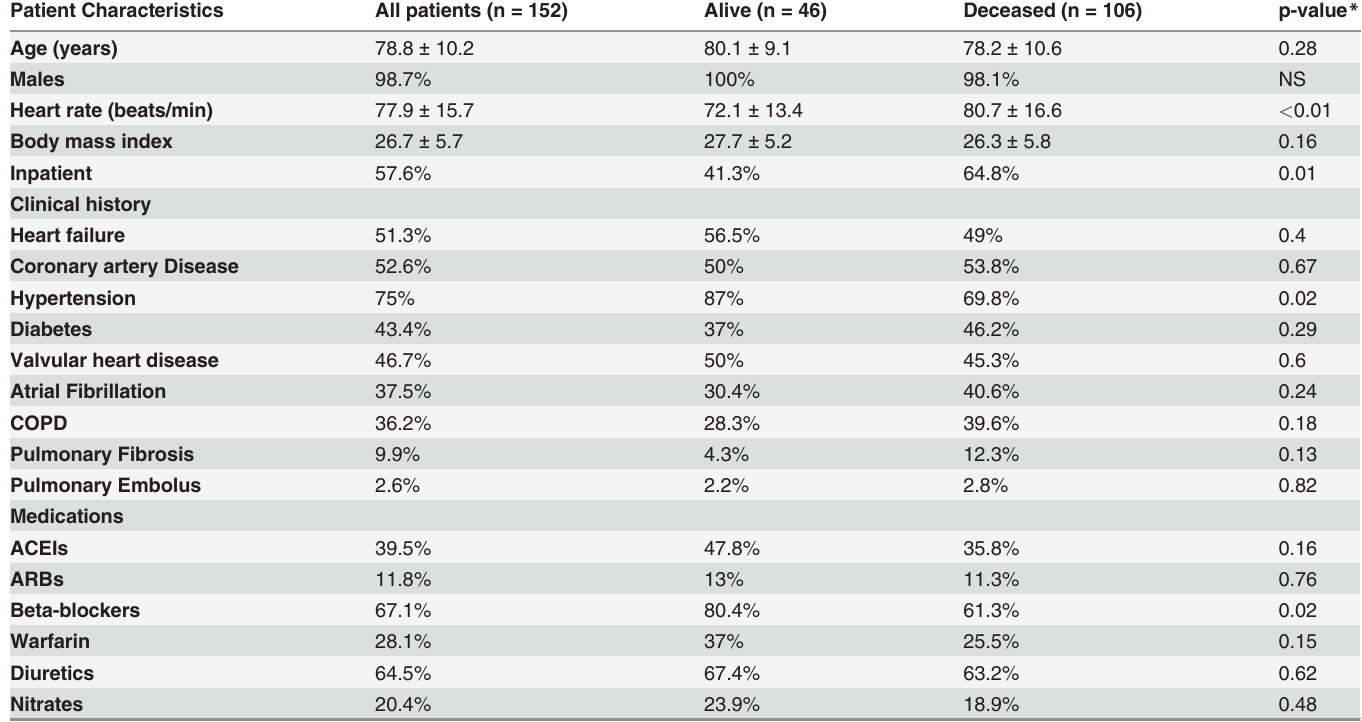
Table 1. Baseline Clinical Characteristics.